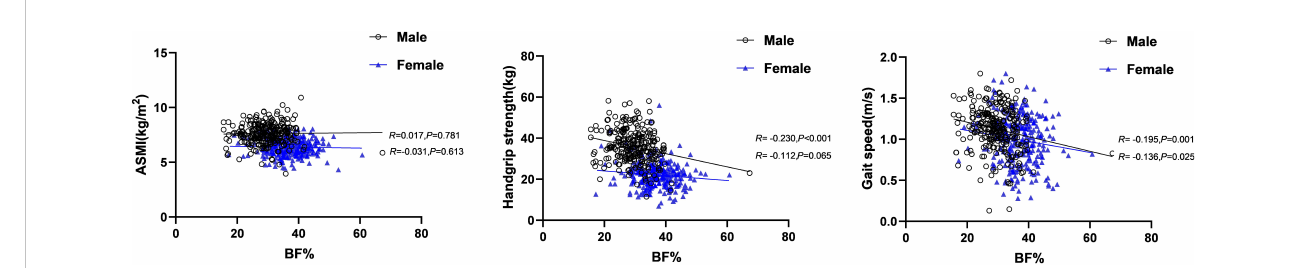
FIGURE 2 Correlations between BF% and the components of sarcopenia. BF%, body fat